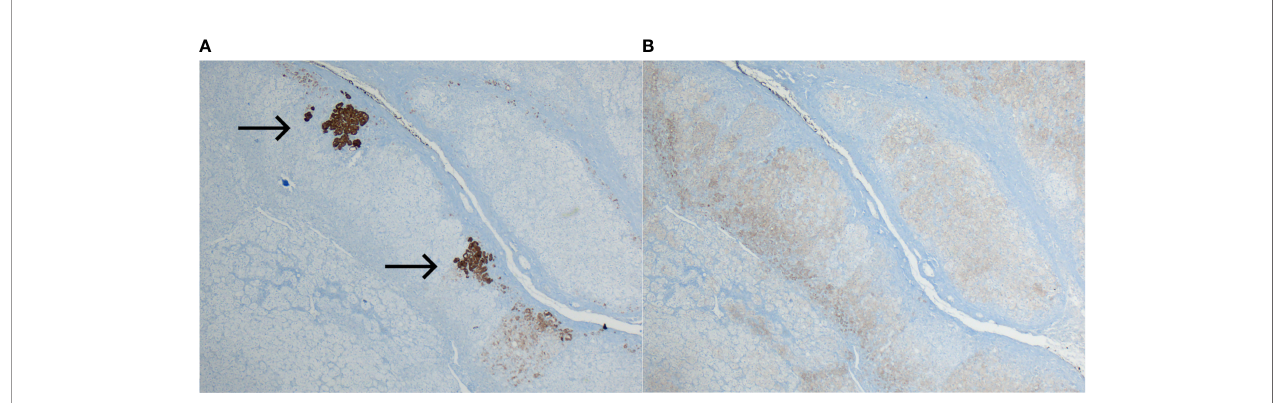
FIGURE 3 | Immunohistochemical analysis of steroidogenic enzymes. (A) Sparse expression of CYP11B2 immunoreactivity in the zona glomerulosa. Only two clusters of ALD-producing cells stained (arrows) in the outer margin of the subcapsular zona glomerulosa (magni fi cation ×4). (B) Normal expression of CYP11B1 in the zona fasciculata (magni fi